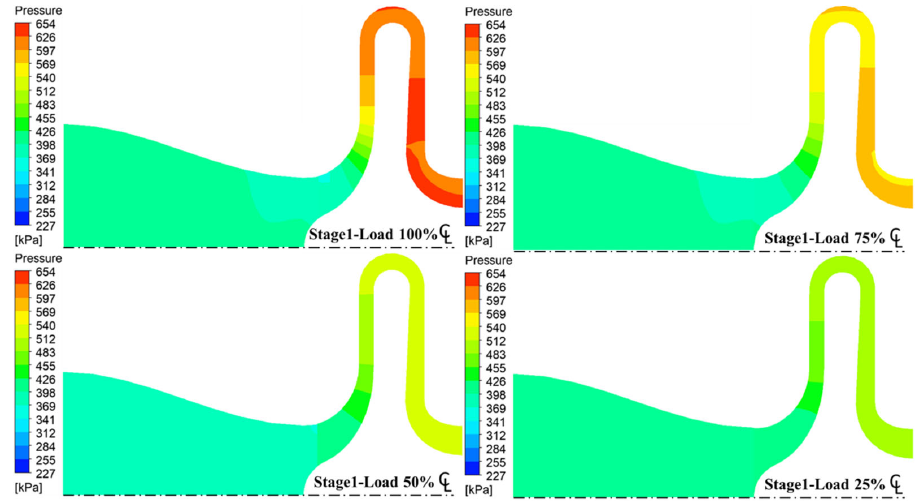
Figure 16. Pressure meridional contour maps of the first stage compression with R ‐ 513A refrigerant under various loads.